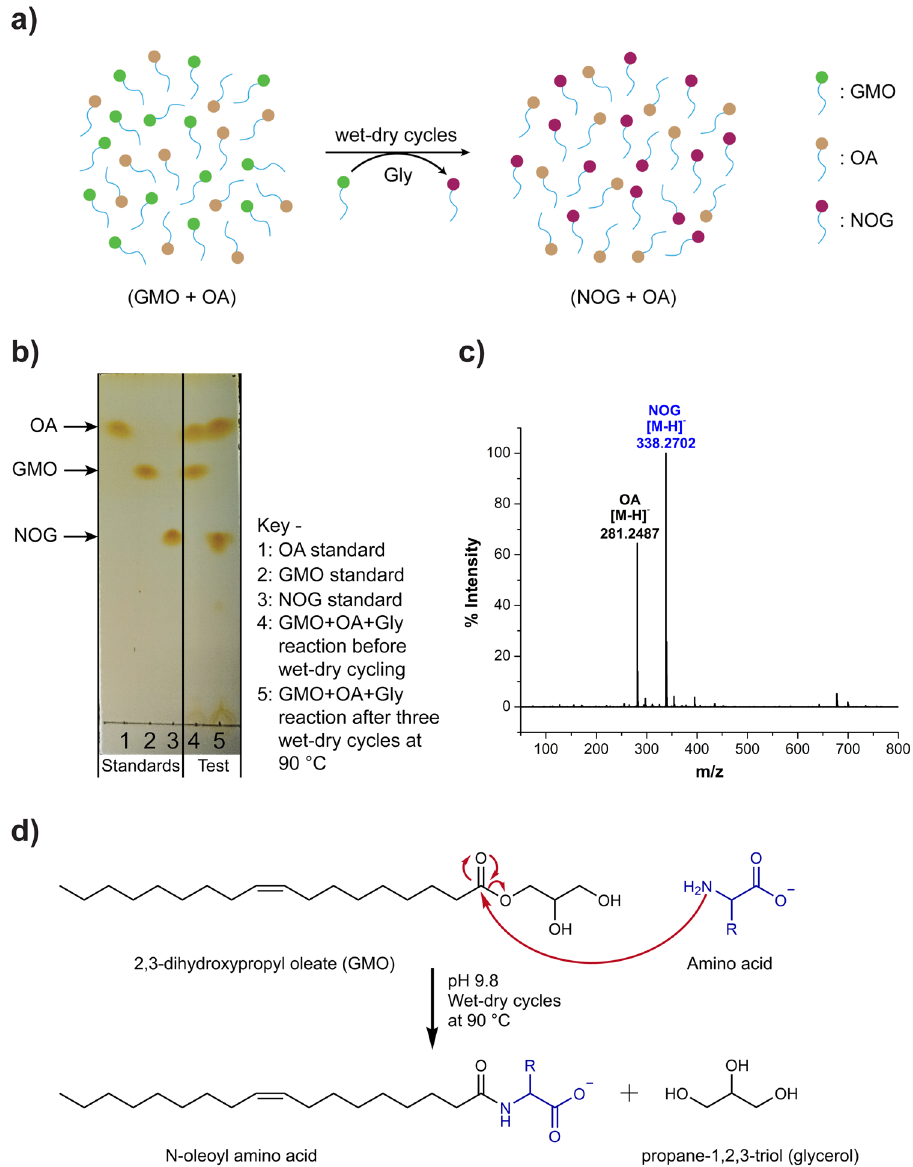
Fig. 1 Conversion of glycerol 1-monooleate (GMO) to N -oleoyl glycine (NOG) in the presence of glycine (Gly) under three wet-dry cycles at 90 °C. The starting concentrations of GMO and Gly were 3 mM and 200 mM, respectively. Initial pH of the reaction was 9.8. The duration of each wet-dry cycle was 24 h. a Schematic overview of the reaction, b TLC analysis shows the complete disappearance of the GMO spot with a concurrent appearance of the NOG spot after wet-dry cycling (lane 5), c HRMS analysis (negative mode) of the fi nal lipid content shows a prominent peak corresponding to NOG (calculated: 338.2701; observed: 338.2702; mass error = 0.3 ppm). Another peak at 281 corresponds to oleic acid (OA) (calculated: 281.2486; observed: 281.2487; mass error = 0.3 ppm), which was added in the initial reaction to increase the solubility of GMO, d A plausible mechanism for NAA synthesis from GMO and amino acid through ester-amide exchange